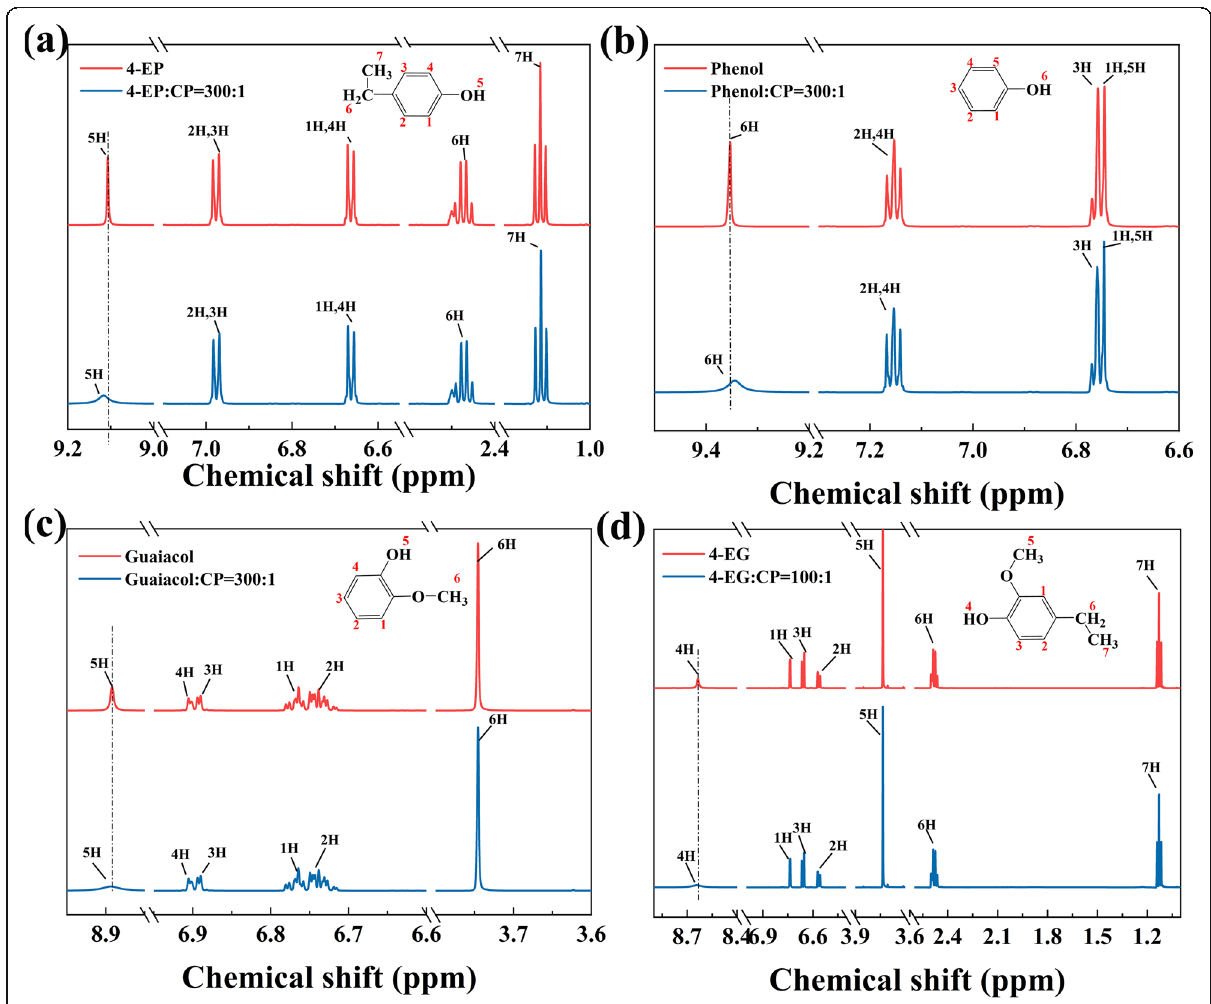
Fig. 3 1 H NMR spectra of CPs with phenolic compounds 4-EP ( a ), phenol ( b ), guaiacol ( c ), and 4-EG ( d